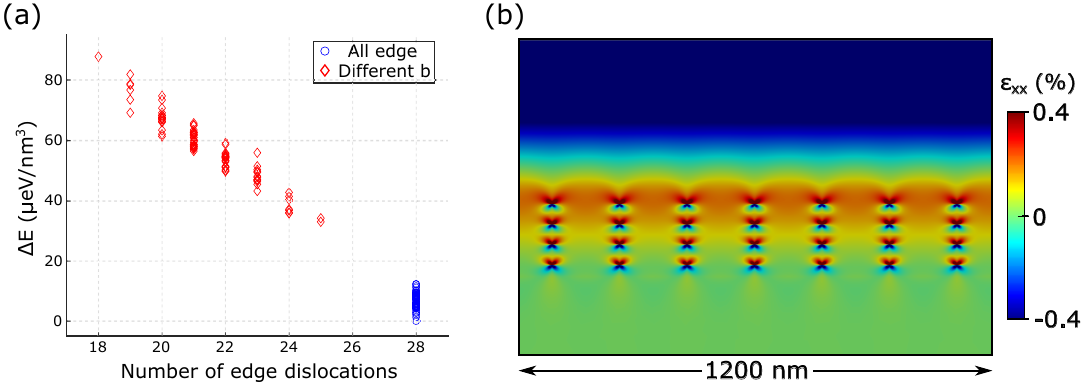
Figure 7. Energy of configurations as a function of the number of edge dislocations present at the end of the steepest descent procedure ( a ). Initial conditions (different Burgers vector or all edge dislocations) have been differentiated by the color of the point. ( b ) Strain map, ε xx component of the minimum energy configuration